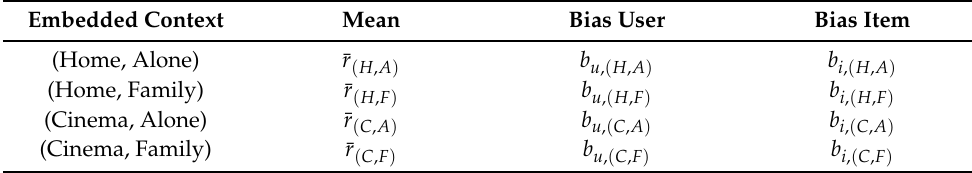
Table 5. Parameters required to obtain the ratings forecasts based on the CBMF method related to Table 3 embedded